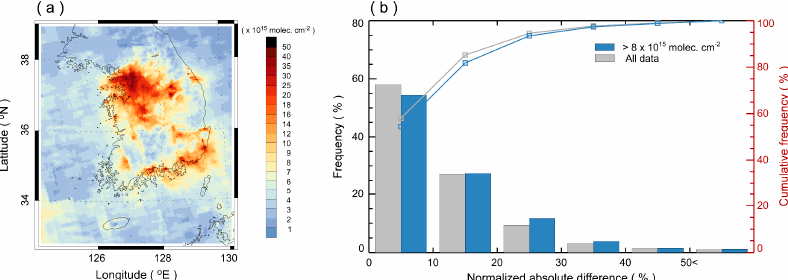
Figure 9. ( a ) The spatial distribution of the reconstructed OMI NO 2 VCD over the South Korean Figure 9. (a) The spatial distribution of the reconstructed OMI NO 2 VCD over the South Korean region and (b) the frequency distribution of the grid-scale normalized absolute region and ( b ) the frequency distribution of the grid-scale normalized absolute di ff erence defined as | | OMI _ DS difference defined as (cid:3627)(cid:3016)(cid:3014)(cid:3010)_(cid:3005)(cid:3020) (cid:3272)(cid:3267)(cid:3255)(cid:3127)(cid:3252)(cid:3283)(cid:3280)(cid:3288) (cid:2879)(cid:3016)(cid:3014)(cid:3010)_(cid:3005)(cid:3020) (cid:3272)(cid:3267)(cid:3255)/(cid:3252)(cid:3262)(cid:3250)(cid:3266) (cid:3627) . − OMI _ DS (cid:2868).(cid:2873)(cid:3435)(cid:3016)(cid:3014)(cid:3010)_(cid:3005)(cid:3020) (cid:3272)(cid:3267)(cid:3255)(cid:3127)(cid:3252)(cid:3283)(cid:3280)(cid:3288) (cid:2878)(cid:3016)(cid:3014)(cid:3010)_(cid:3005)(cid:3020) (cid:3272)(cid:3267)(cid:3255)/(cid:3252)(cid:3262)(cid:3250)(cid:3266) (cid:3439) WRF / CMAQ WRF − Chem 0.5 ( OMI _ DS WRF − Chem + OMI _ DS WRF / CMAQ )